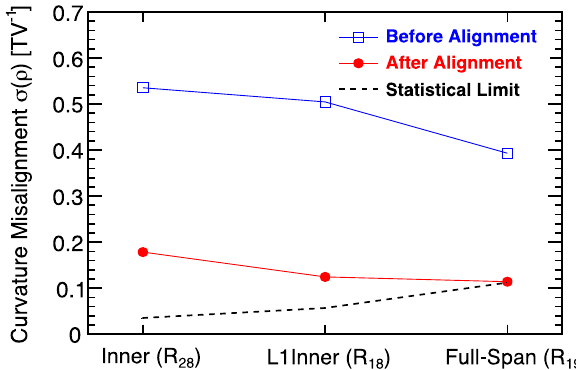
Fig. 24 The curvature misalignments, defined as the standard devia- tions of curvature biases of the 1000 most populated ladder combina- tions, σ(ρ), for the track patterns of the inner tracker ( R 28 ), L1 and the inner tracker ( R 18 ), and the full-span tracker ( R 19 ) before (open squares) and after (full circles) the static alignment. The statistical lim- its(dashedline)duetotheuncertaintiesarisingfromthelimitednumber of cosmic-ray events at high rigidities in the curvature bias determina- tion are also